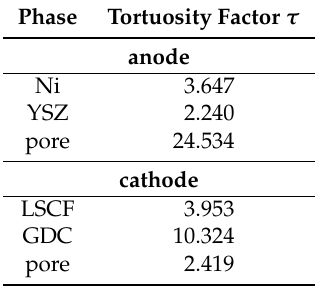
Table 6. Tortuosity factors of each phase.